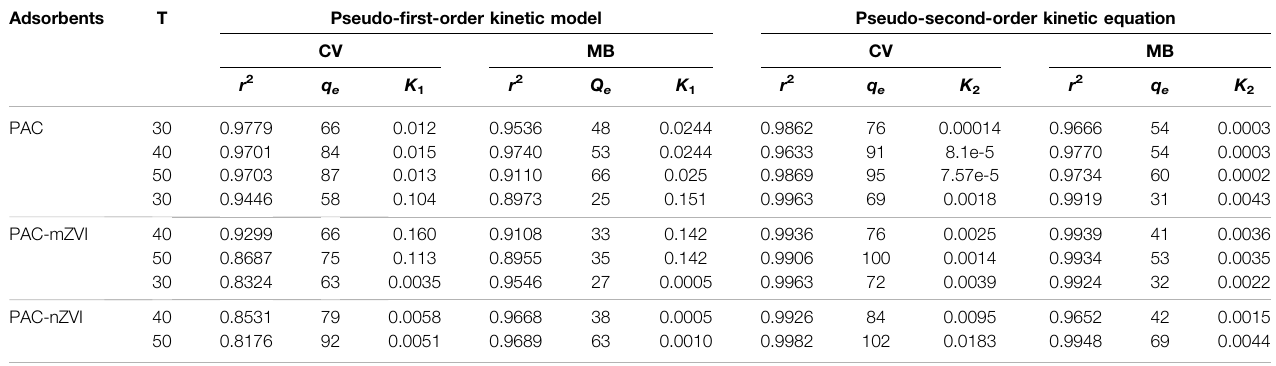
TABLE 2 | Kinetic parameters for the adsorption of CV and MB dye on PAC and PAC-based ZVI adsorbents. Adsorbents T